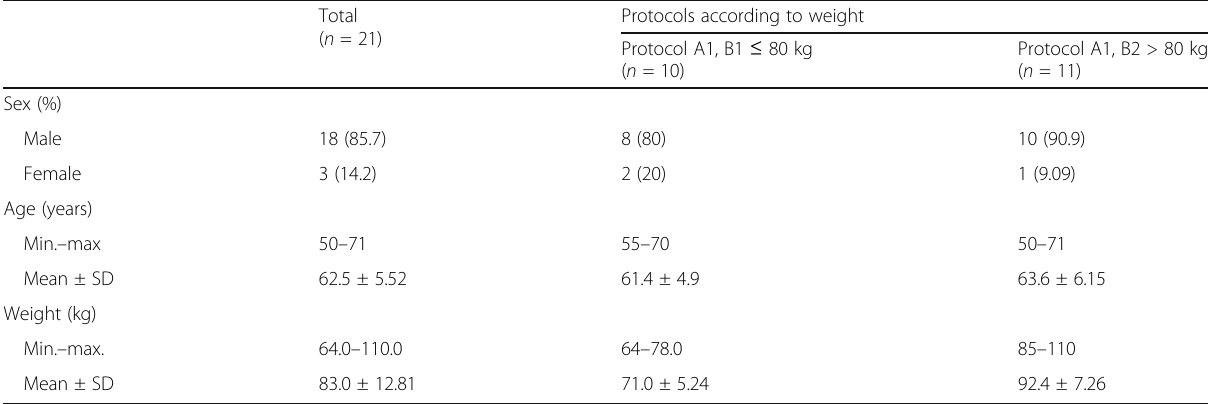
Table 1 Distribution of the studied cases according to demographic data ( n = 21)